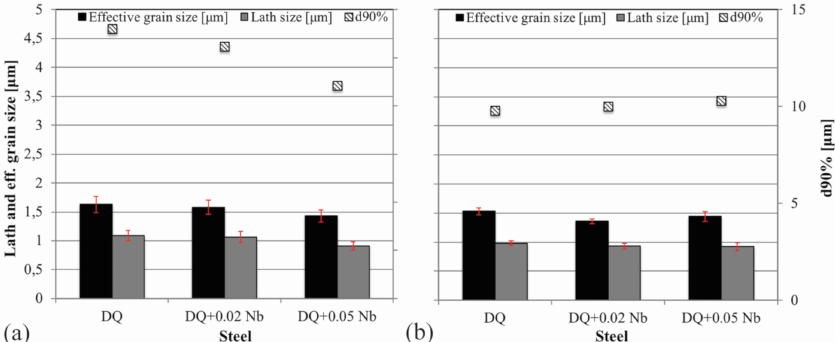
Figure 11. E ff ective grain, lath sizes and coarsest grains (d90%) of the specimens. ( a ) FRT 920 ◦ C, ( b ) 820 ◦